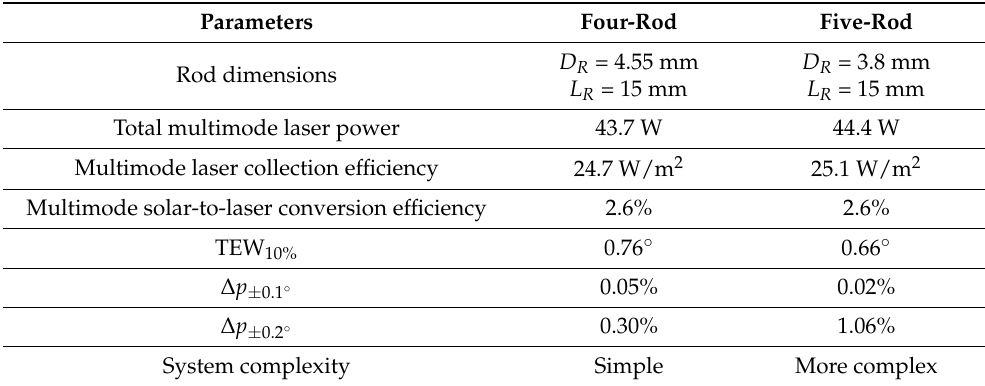
Table 1. Multimode solar laser performance of both the four-rod and the five-rod schemes regarding solar laser efficiencies and solar tracking error compensation capacity. Parameters Four-Rod Five-Rod Rod